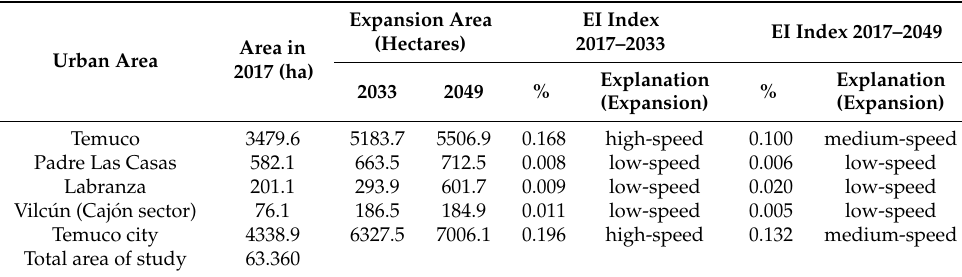
Table 7. Expansion Intensity (EI) Index for the city of Temuco through to 2033 and 2049. Source: Authors’